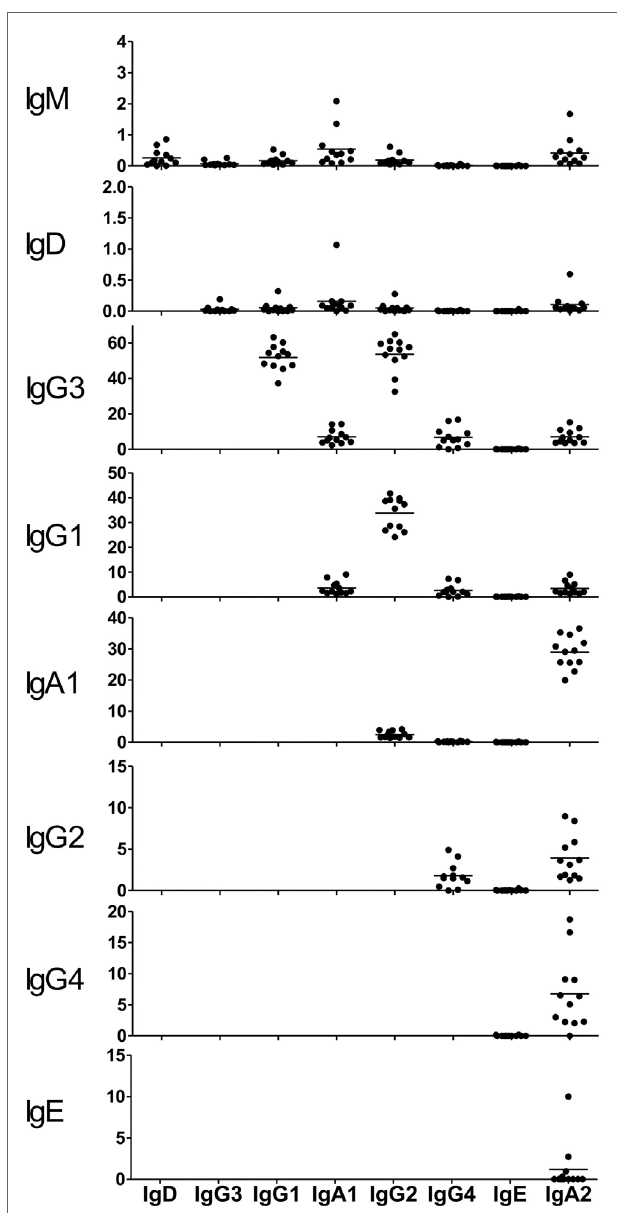
FigUre 6 | clone sharing among immunoglobulin (ig) isotypes and subclasses . The proportions of clones shared between two subclasses are shown. Each dot represents an individual. Sequence reads sharing identical V, D, and J segments and identical amino acid sequences of CDR3 were considered as being from identical clonal lineages. The proportions were calculated by dividing the number of shared clones by the total number of ancestral Ig (upstream). Each Ig isotype and subclass is shown in the order corresponding to the genomic location of IGHC regions